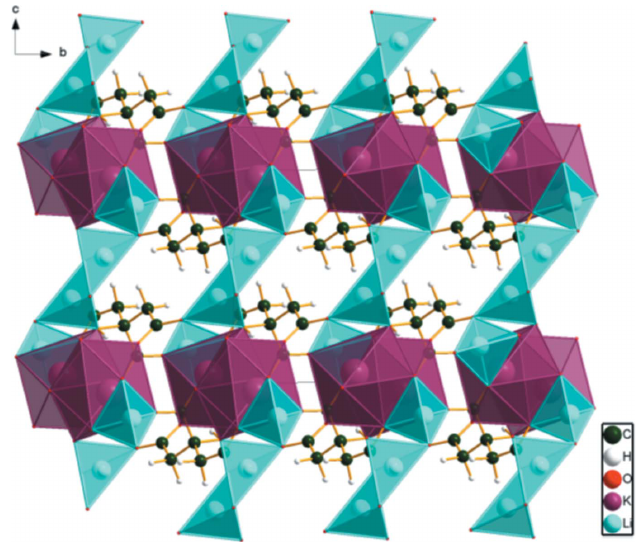
Figure 3 Crystal structure of Li 2 KC 6 H 5 O 7 , viewed down the a -axis direction.